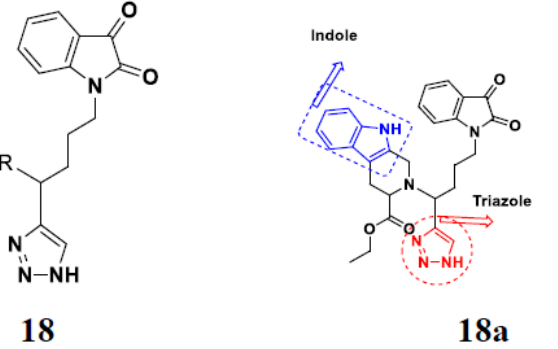
Figure 20. Structure of indole-ospemifene-triazole based hybrids and the most promising com- pound 18a. Table 18. In vitro cytotoxic activities of indole-isatin-triazole based hybrid compounds 18 ( b – c ). Compound